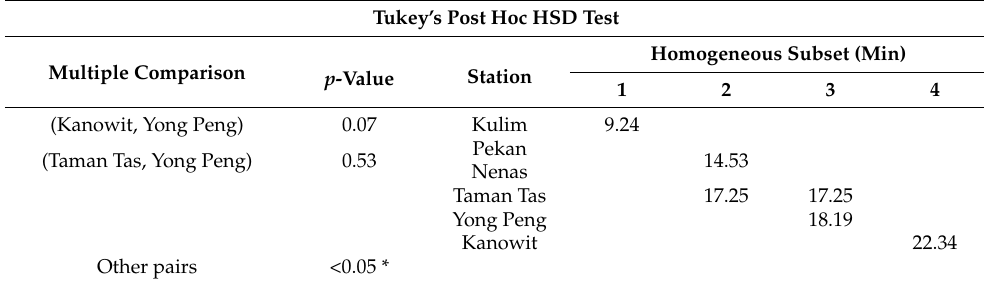
Table 7. Summary of Tukey’s post hoc HSD test for mean response time between category C fire stations.